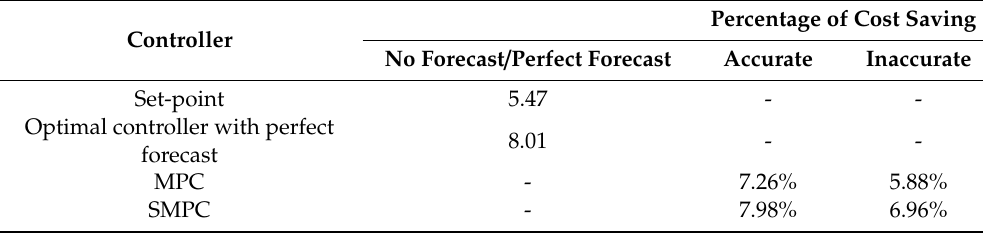
Table 2. The percentage of annual electric energy cost saving to the annual electricity energy